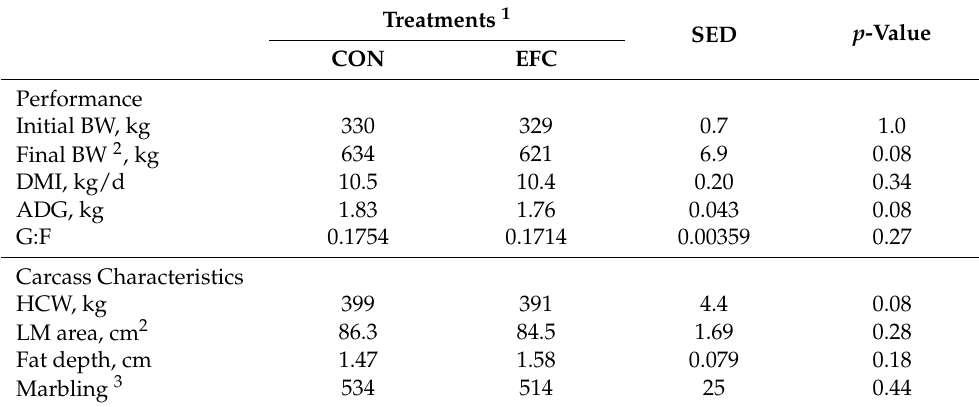
Table 5. Main effect of the corn hybrids (CON vs. EFC) when fed as high-moisture corn in diets with 35% Sweet Bran ® on predicted least-square means when finishing cattle performance and carcass characteristics are